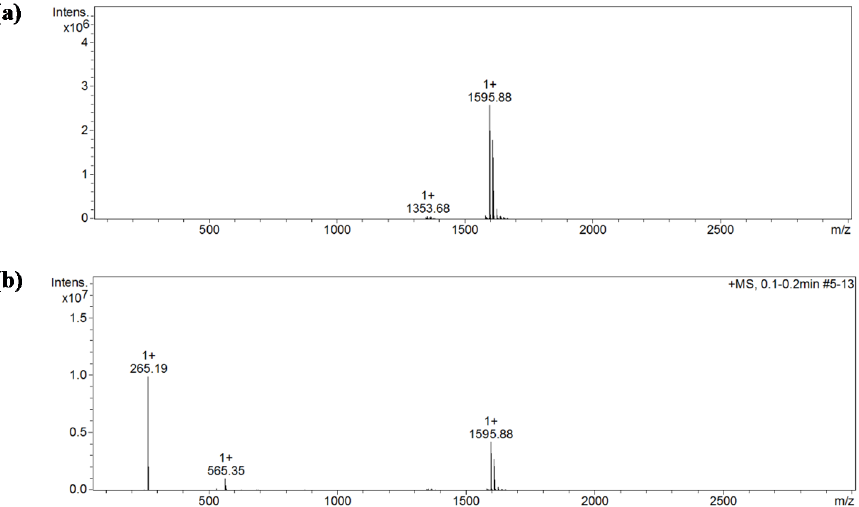
Figure 3. The spectrum of MIA+DM- β -CD: ( a ) The range of scanning from 100 to 3000 m/z . MS mode; MS/MS spectra in the MRM mode, without fragmentation-CID energy 0 eV, with mianserin + DM- β -CD at 1595.88 m/z, and probably some amount of RM- β -CD at 1353.68 m/z as impurity with degree of substitution (DS) between 15 and 16. This is higher than 14, which is an average DS characteristic for DM- β -CD. ( b ) The range of scanning from 100 to 3000 m/z . MS mode; MS/MS spectra in the MRM mode, with fragmentation-CID energy 50 eV, with mianserin at m/z 265.19, mianserin + DM- β -CD at 1595.88 m/z, and dimer mianserin + mianserin hydrochloride at m/z 565.35.